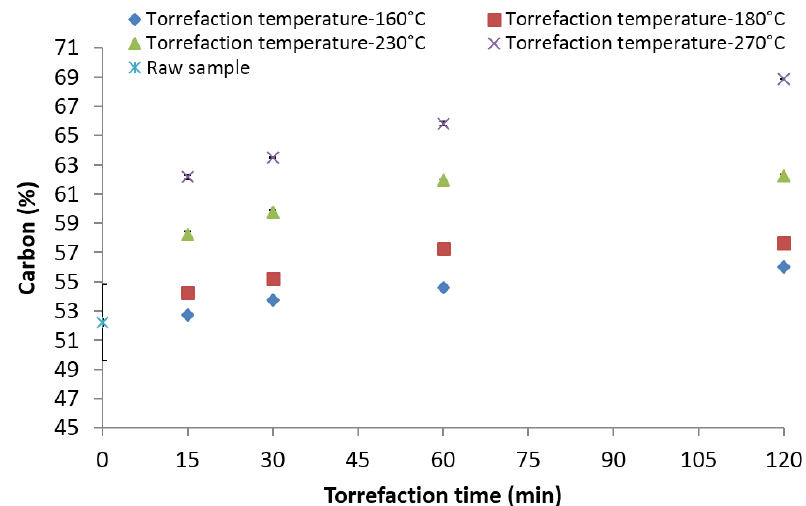
Figure 8. Carbon content in ground lodgepole pine with respect to the torrefaction time Figure and temperature.